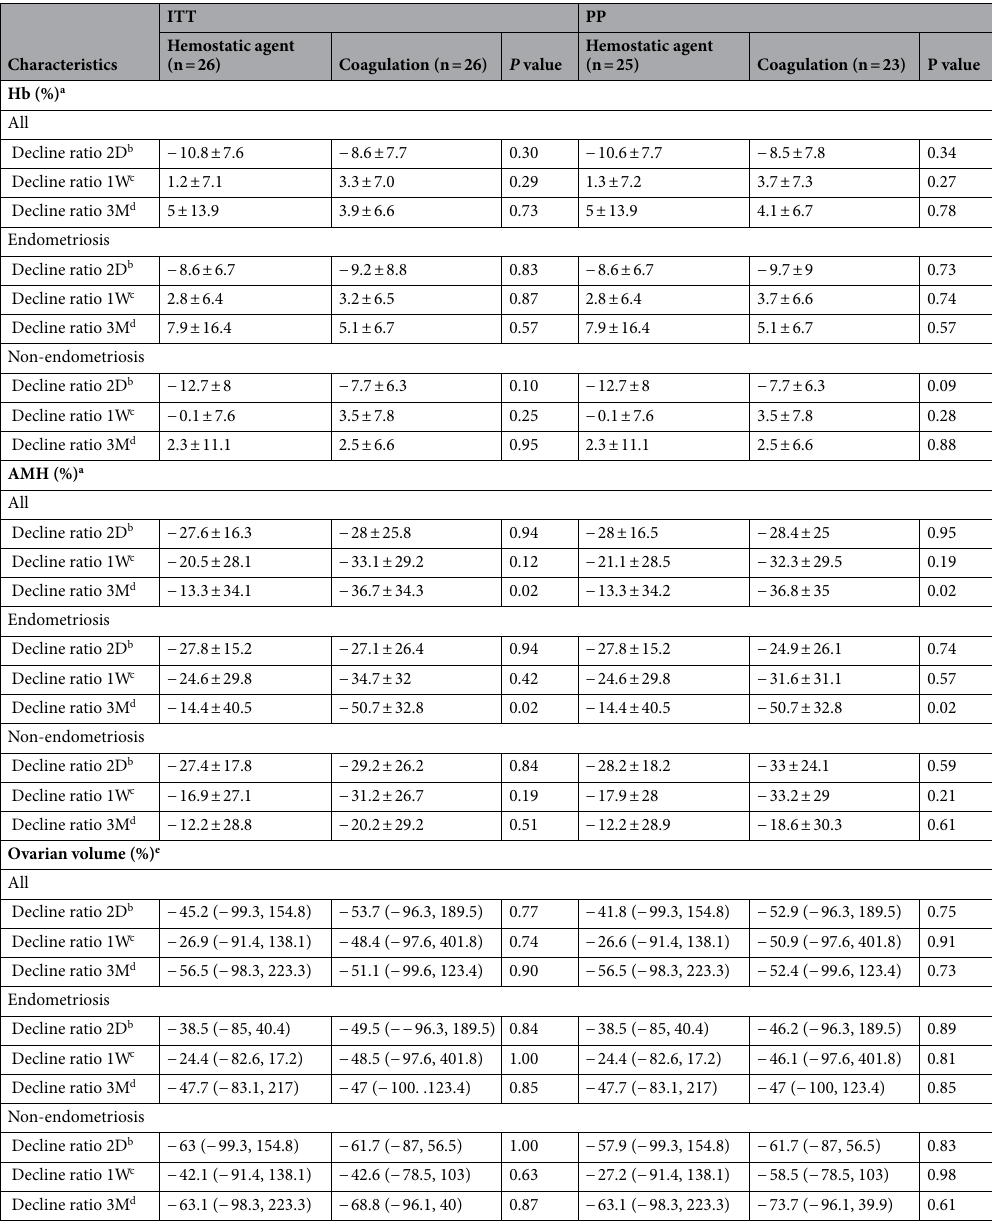
Table 4. Comparison of decline ratio of hemoglobin (Hb) levels and serum anti-Müllerian hormone (AMH) levels, and ovarian volume in the intention-to-treat (ITT) and the per-protocol populations (PP). a Data were shown as mean ± standard deviation. b Defined as (the value at 2 days after surgery—the value just before surgery)/the value just before surgery × 100. c Defined as (the value at 1 week after surgery—the value just before surgery)/the value just before surgery × 100. d Defined as (the value at 3 months after surgery − the value just before surgery)/the value just before surgery × 100. e Data were shown as median with